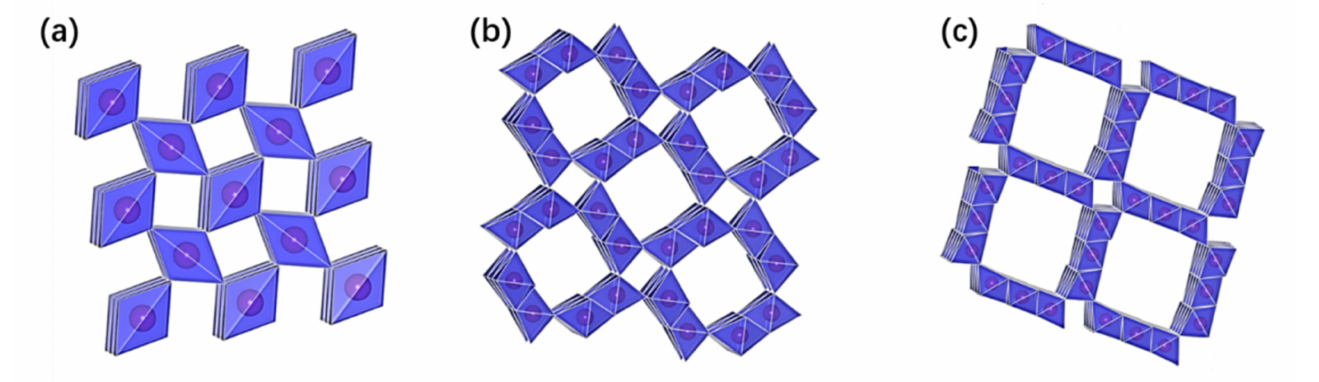
Figure 1. Tunnel structure of MnO 2 : ( a ) β -MnO 2 (1 × 1, 2.3 Å × 2.3 Å), ( b ) α -MnO 2 (2 × 2, 4.6 Å × 4.6 Å), ( c ) t-MnO 2 (3 × 3, 6.9 Å × 6.9